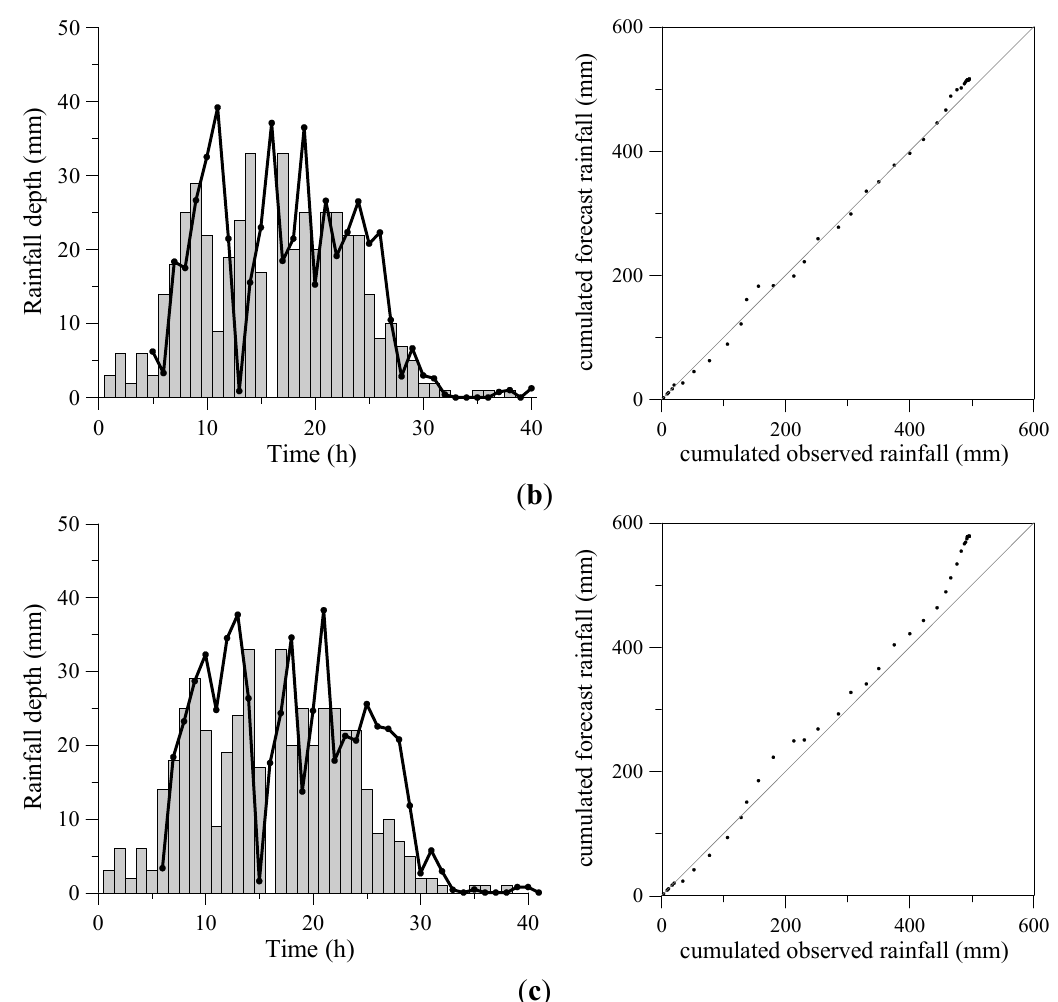
Figure 5. Grey model for rainfall forecasting in San-Hsia watershed: ( a ) 1-h ahead; ( b ) 2-h ahead; ( c ) 3-h